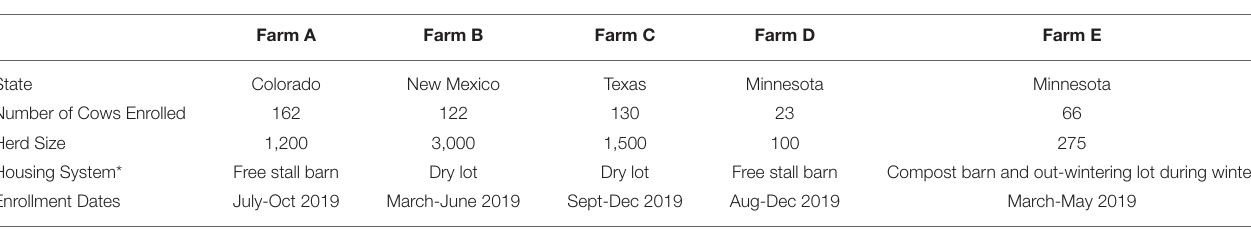
TABLE 1 | Herd characteristics for each farm enrolled in the